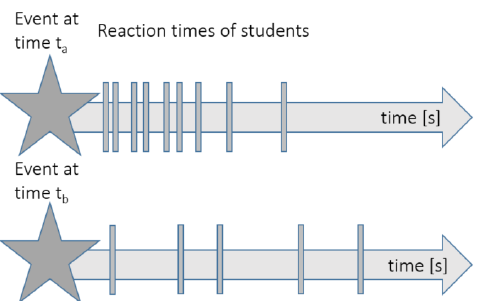
Figure 5. Illustration of a hypothesis of this study: when students are more engaged, they are more likely to react, and in a faster